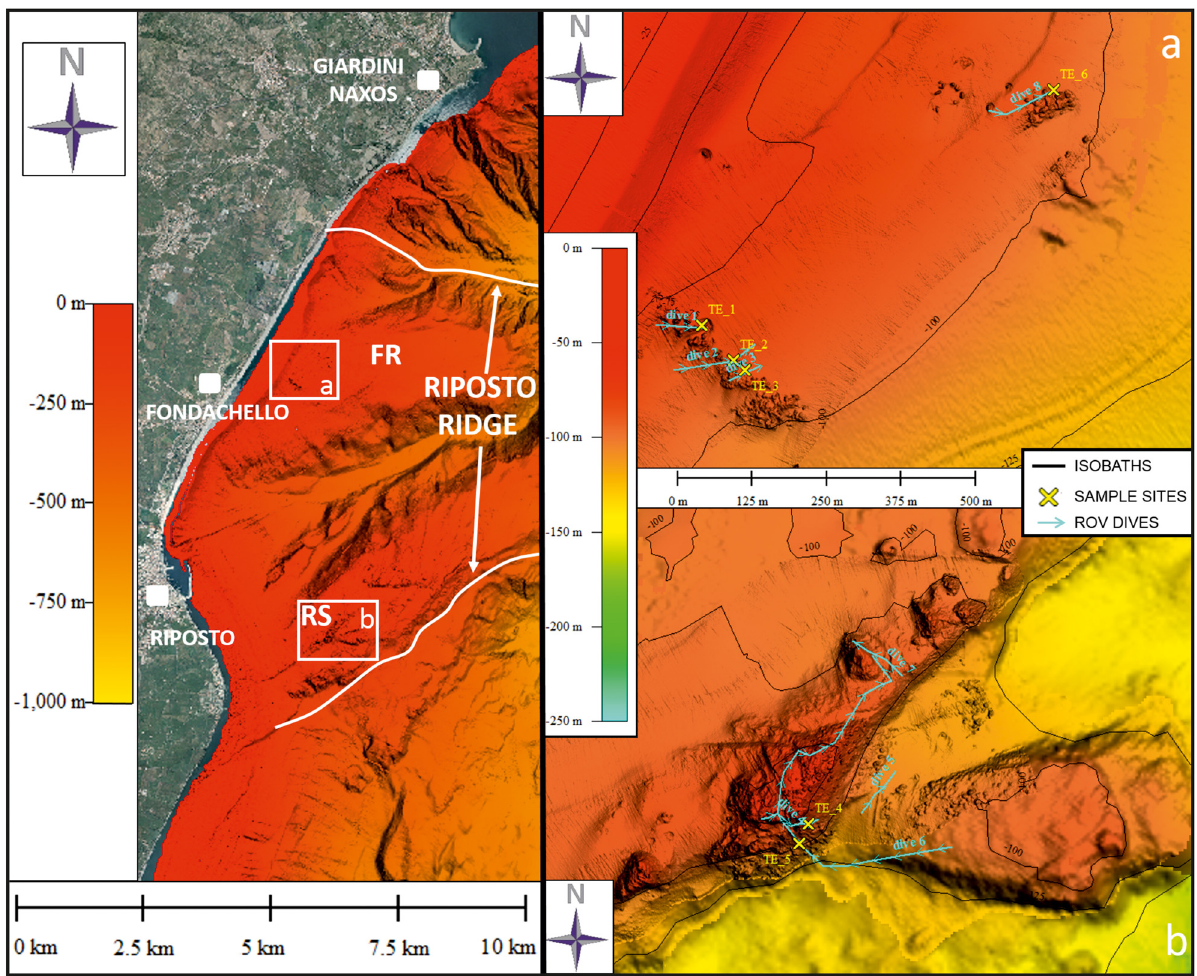
Figure 7. ROV dives (with indication of the sample sites) carried out on the shallowest portion of the Riposto Ridge: FR (Fondachello Ridge), RS (Riposto